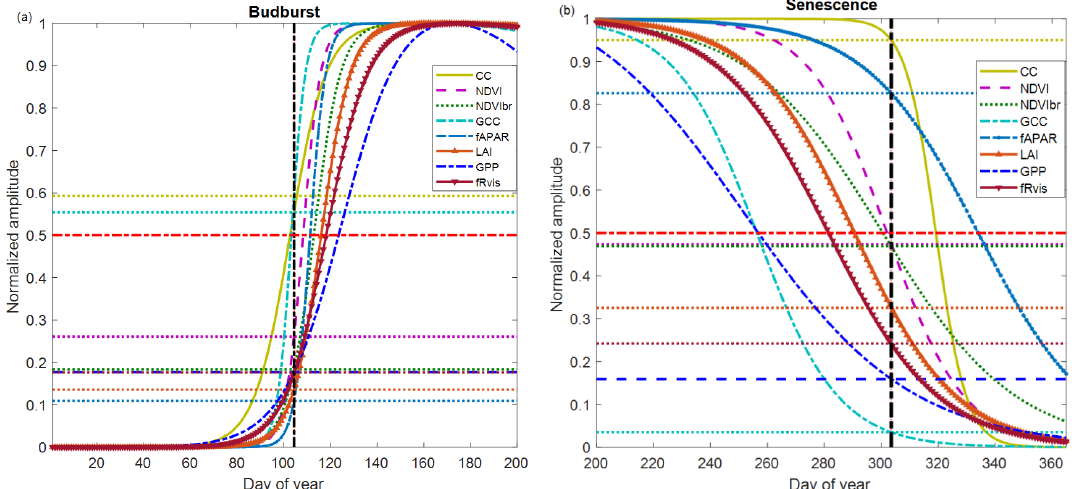
Figure 5. Average phenological patterns during budburst (a) and senescence (b) during the period 2012–2017 using modeled time series through an ADS function fitted to the measured time series of NDVI (Normalized Difference Vegetation Index), GCC (greenness chromatic coordinate), broadband NDVI (NDVI br ), LAI (leaf area index), f APAR, CC (canopy closure), f R vis (fraction of reflected radiation) and GPP (gross primary production). Amplitudes of variations are normalized to 1. Horizontal dotted lines: for each variable, the proportion of the average amplitude that equals the average of the BB-OBS (Fig. 5a) and LS-OBS (Fig. 5b) dates. Horizontal bold red line ( y axis = 0.5): mid-amplitude (50%) corresponding to mid-onset of spring (MOS) and mid-onset of senescence (MOF). Vertical black line: averages of observed phenological dates during 2012–2017 for budburst (BB-OBS) and for senescence